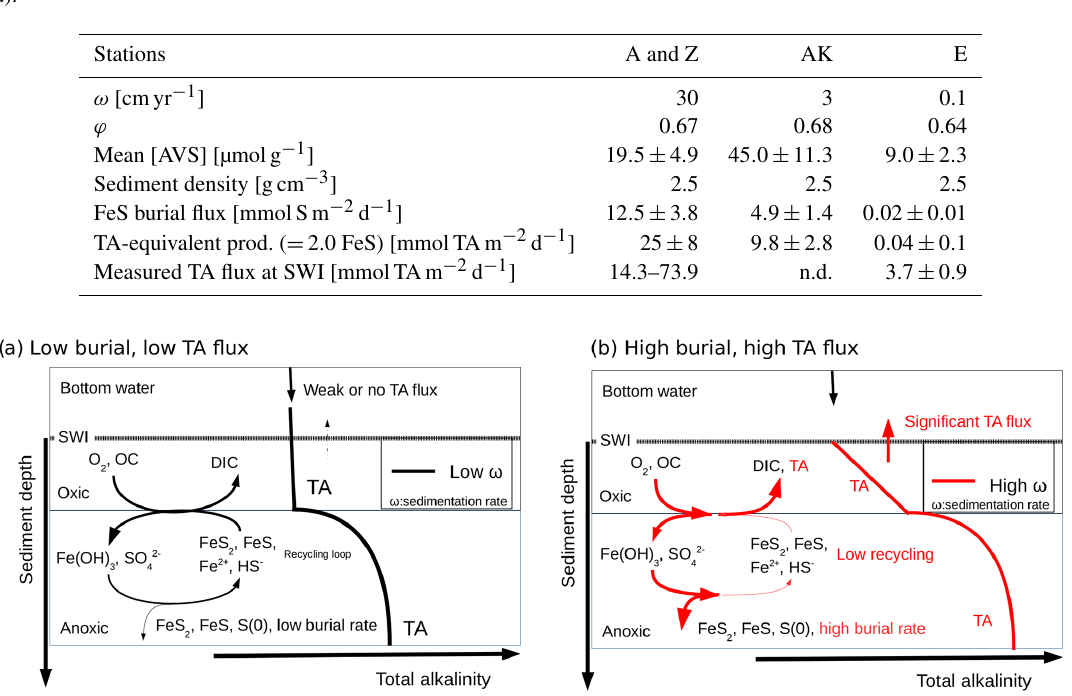
Table 4. Calculated FeS burial fluxes and their TA-equivalent production at each station compared to measured TA benthic fluxes (n.d. = not determined).